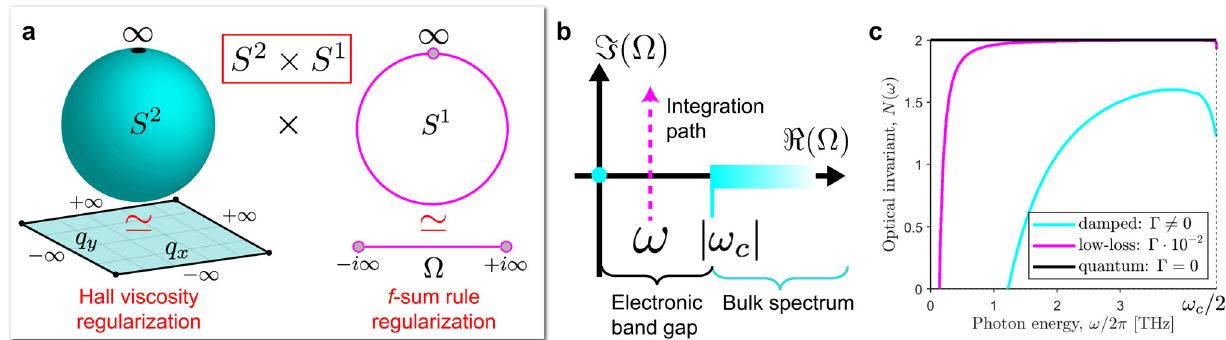
Fig. 2 Visualization of the 2 + 1D momentum space in the continuum limit. a Due to regularization from viscosity, the q space is equivalent to the sphere R 2 ’ S 2 as all paths at q = ∞ are compacti fi ed into a single point. Likewise, the f -sum rule ensures imaginary contours in Ω space are compacti fi ed to a circle R ’ S 1 . The product of these two spaces S 2 × S 1 is a 2 + 1D manifold without boundary. b Contour in the complex frequency plane used to evaluate the optical N -invariant. Integration is performed vertically Ω ∈ ( ω − i ∞ , ω + i ∞ ) over all Matsubara frequencies. ω = ℜ ( Ω ) is the photon energy that lies within the electronic band gap 0 < ω < ∣ ω c ∣ . c Optical invariant N ( ω ) as a function of the photon energy ω . The N -invariant is calculated for damped, low- loss, and quantum Hall fl uids in the nontrivial repulsive regime ω c ν H > 0. In the dissipationless limit Γ = 0, the optical invariant is quantized to ∣ N ∣ = 2 within the entire band